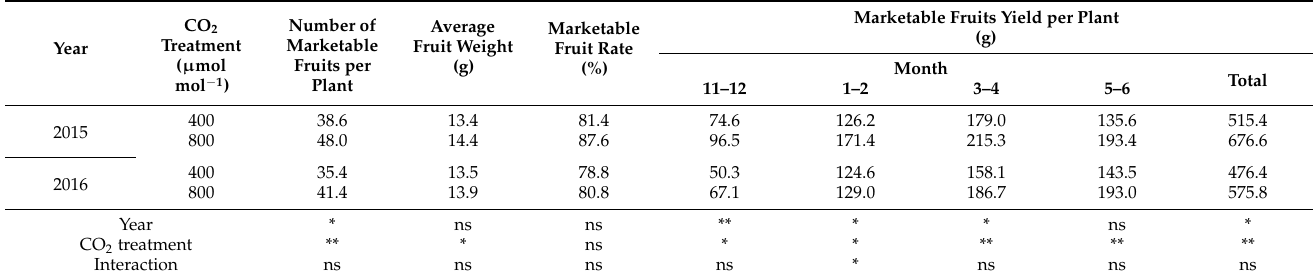
Figure 3. The change in ventilation rate, CO 2 enrichment status, CO 2 concentration, and air temper- ature in the greenhouse, solar radiation in the sunny day ( a , b , c ) and cloudy day ( d , e , f ). The sunny day ( a , b , c ) is 28 January 2017, total solar radiation was 14.79 MJ m − 2 . The cloudy day ( d , e , f ) is 12 January 2017, total solar radiation was 5.40 MJ m −2 . CO 2 enrichment status means ON: 10, OFF: 0. CO 2 concentration was controlled that 400 µmol mol − 1 treatment was kept more than 400 µmol mol − 1 in all day and 800 µmol mol − 1 treatment was kept more than 800 µmol mol − 1 and 400 µmol mol − 1 during no ventilation and ventilation, respectively. Figure 4. Effect of different concentrations of CO 2 enrichment on the growth of strawberry ‘Sagahonoka’ ( ( a ): Plant height, ( b ): Leaf length × Leaf width). CO 2 concentration was controlled that 400 µmol mol −1 treatment was kept more than 400 µmol mol −1 in all day and 800 µmol mol −1 treatment was kept more than 800 µmol mol −1 and 400 µmol mol −1 during no ventilation and ventilation, respectively. * Is significantly different at 5% levels, respectively, by t -test. Table 1. Effect of different concentrations of CO 2 enrichment on number of marketable fruits, average fruit weight, marketable fruits rate, and marketable fruits yield of strawberry ‘Sagahonoka’.